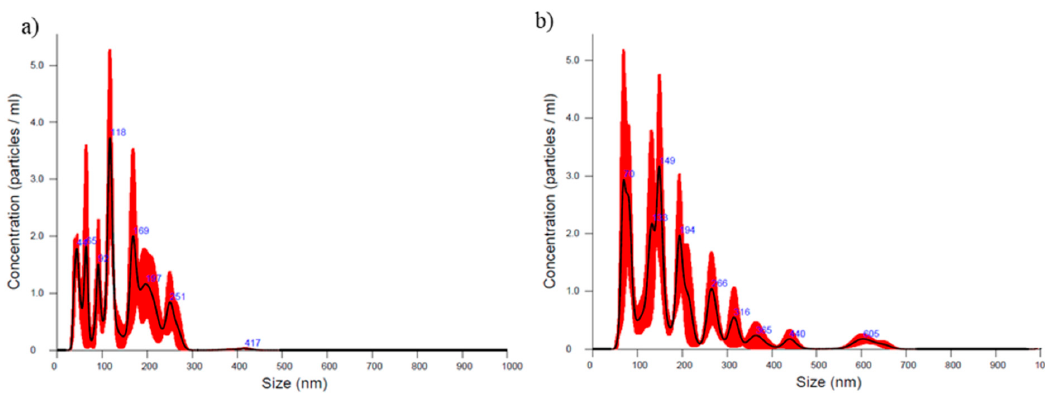
Figure 5. Particle size distribution patterns for ( a ) TiO 2 (5 nm) and ( b ) TiO 2 (15 nm).